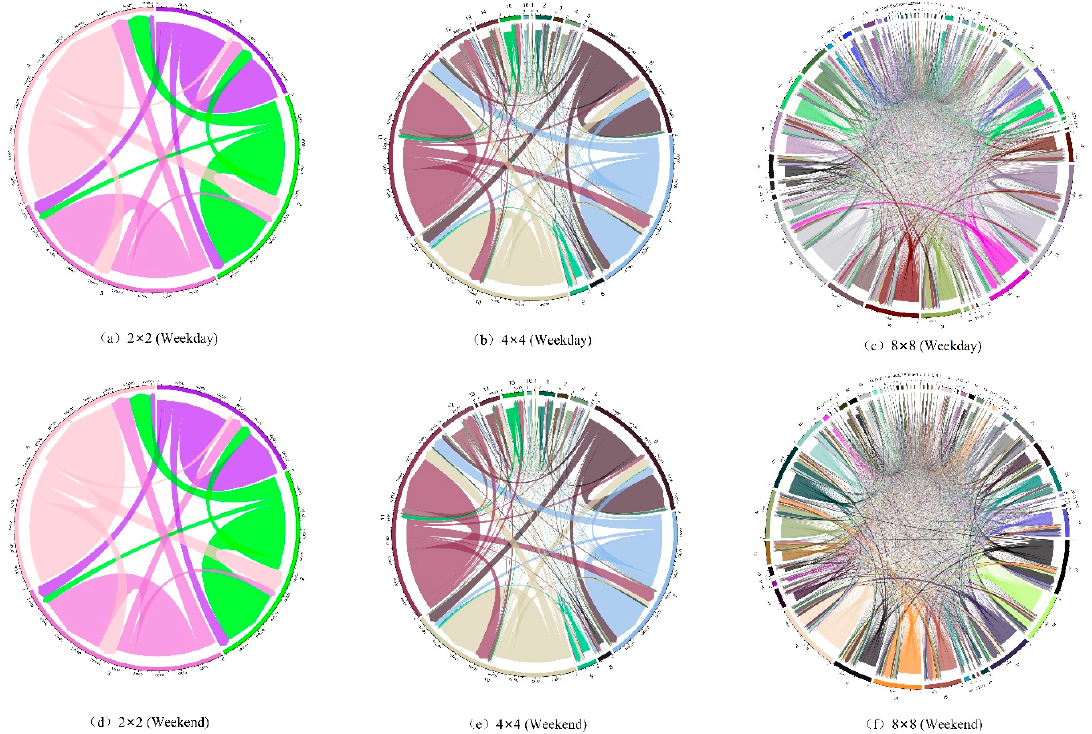
Figure 16. Spatial multiscale visualizations for taxi OD data in Beijing based on the chord diagram plot.